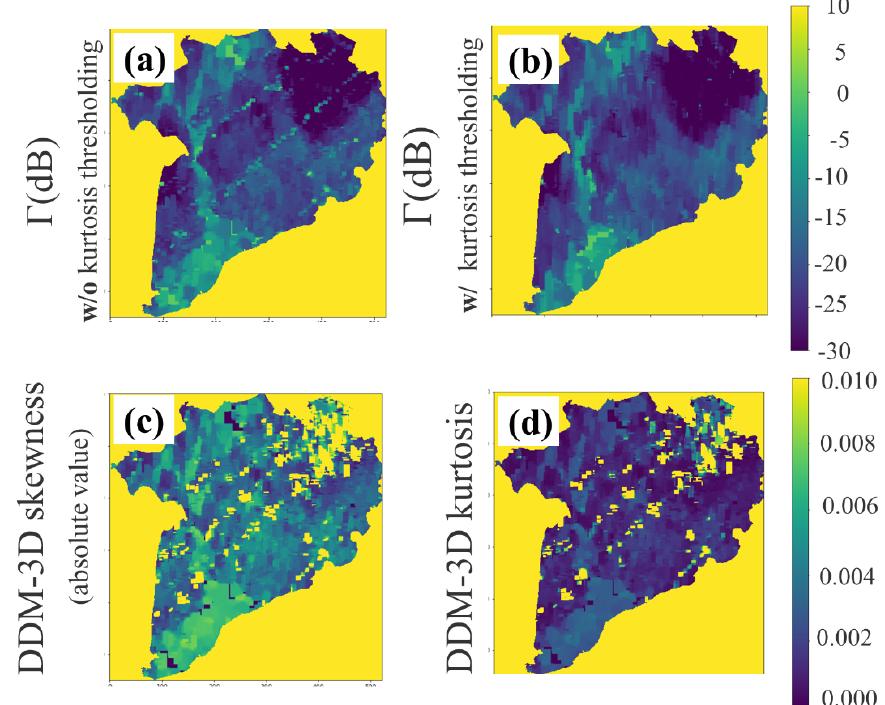
Figure 5. A sample of the Lv. 3 15 − day − cycle Kalman smoother product based on the precision index [ Γ (dB) without or with applying the precision index ( a , b ), zeroed out based on the kurtosis threshold and DDM 3D statistics such as skewness ( c ) and kurtosis ( d )] clipped at Mekong Delta on 1 August 2018.